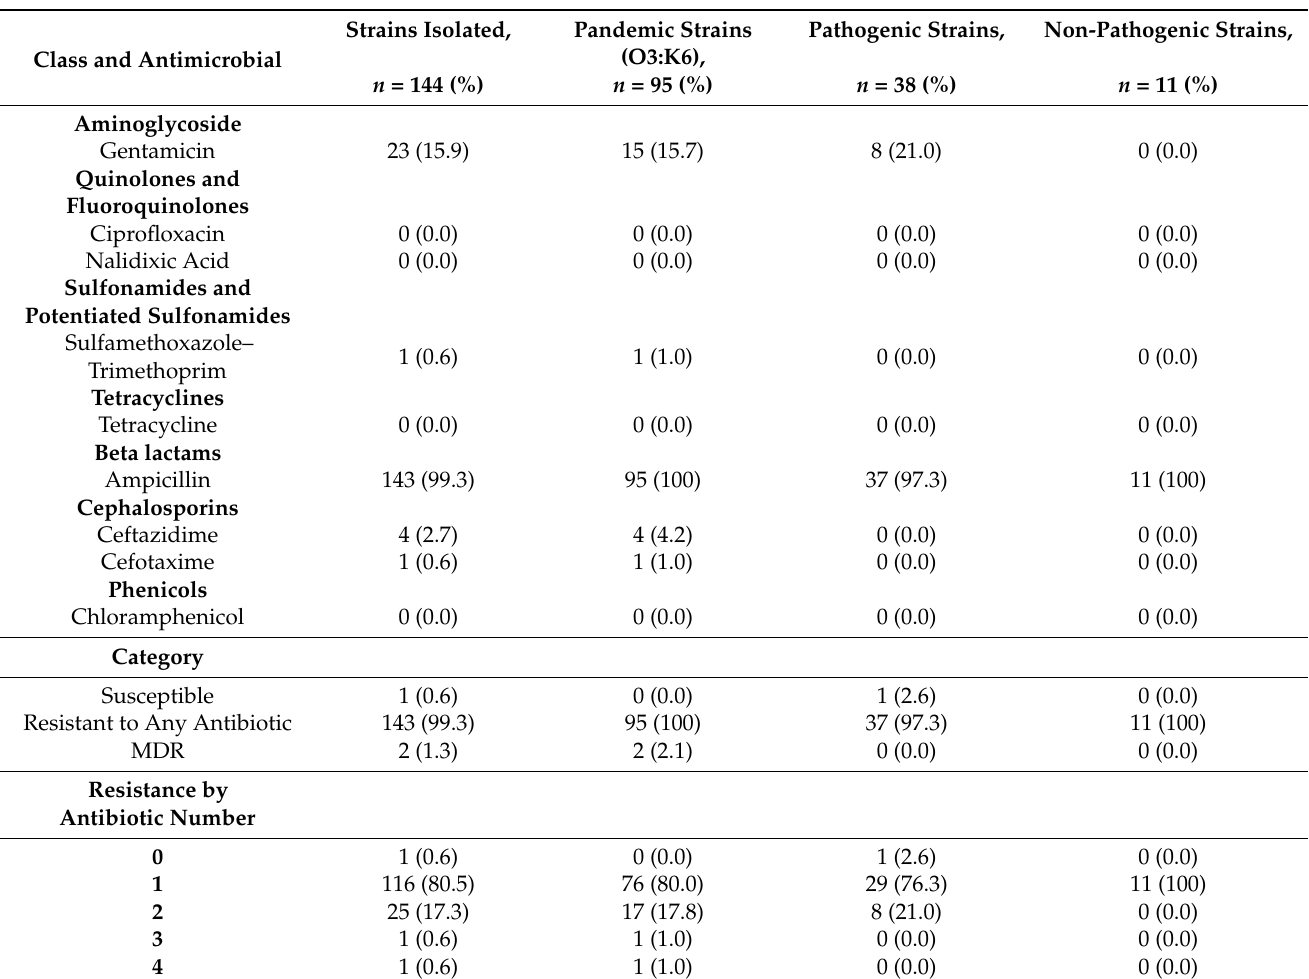
Table 5. Antibiotic resistance of Vibrio parahaemolyticus isolates from diarrhea cases in Mexico from 2004 to